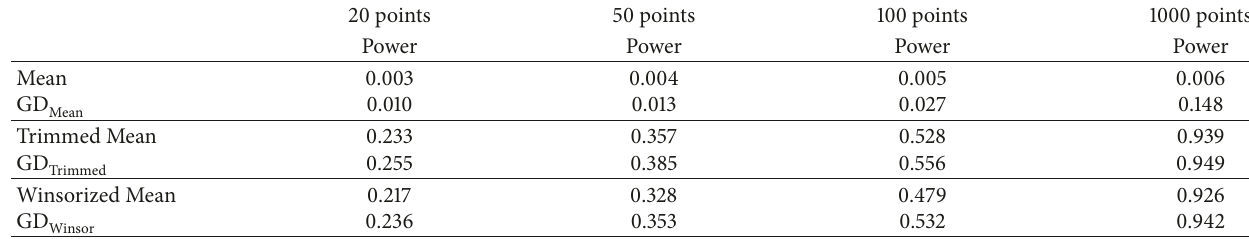
Table 69: G-h distributions with 50% noise level.